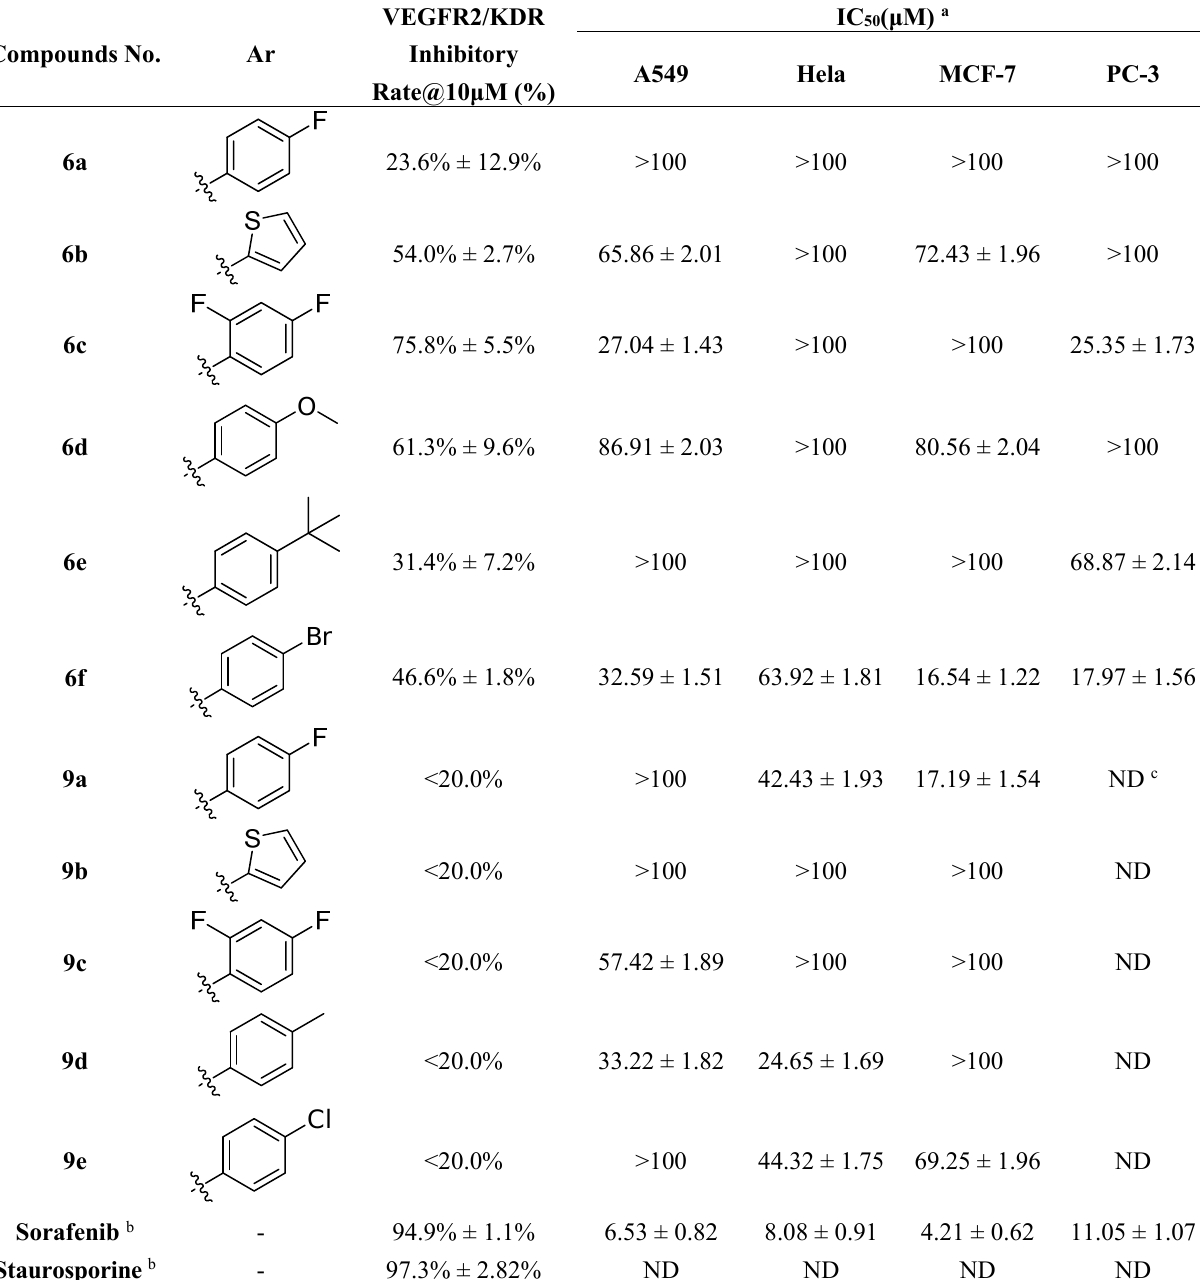
Table 1. Structures and activity of target compounds 6a – f and 9a – e . Compounds